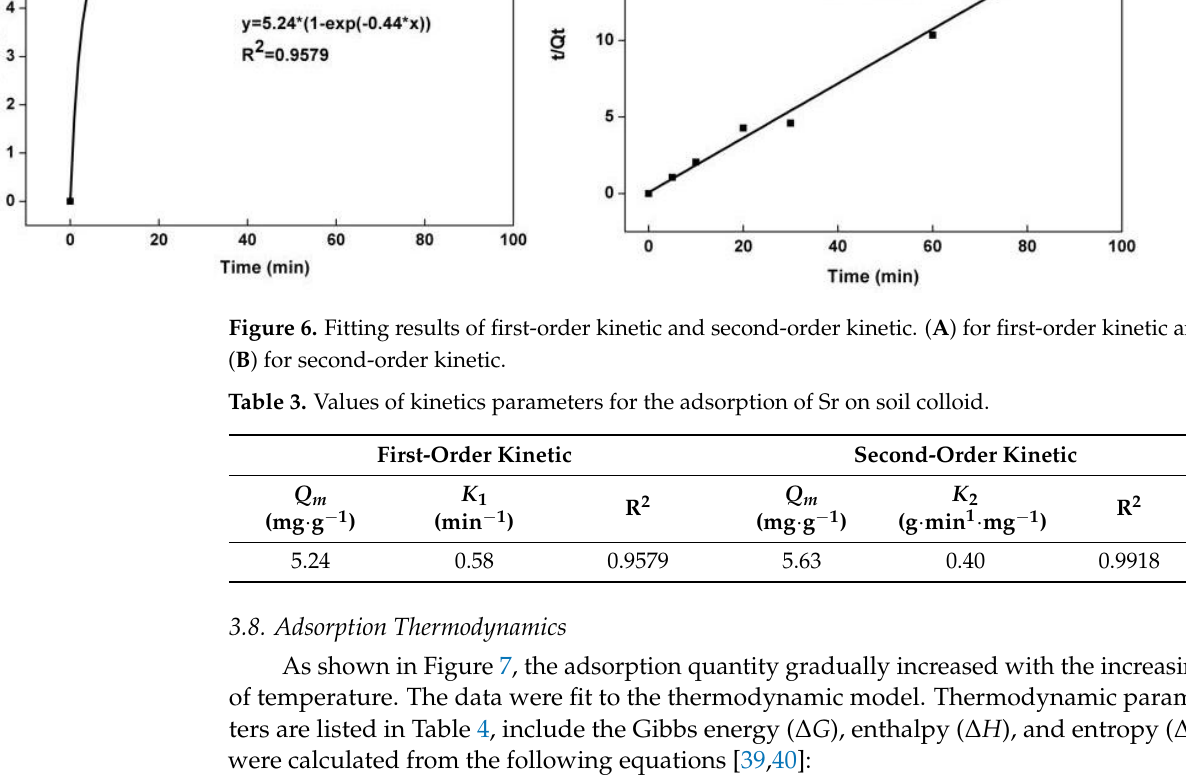
Table 3. Values of kinetics parameters for the adsorption of Sr on soil colloid. First-Order Kinetic